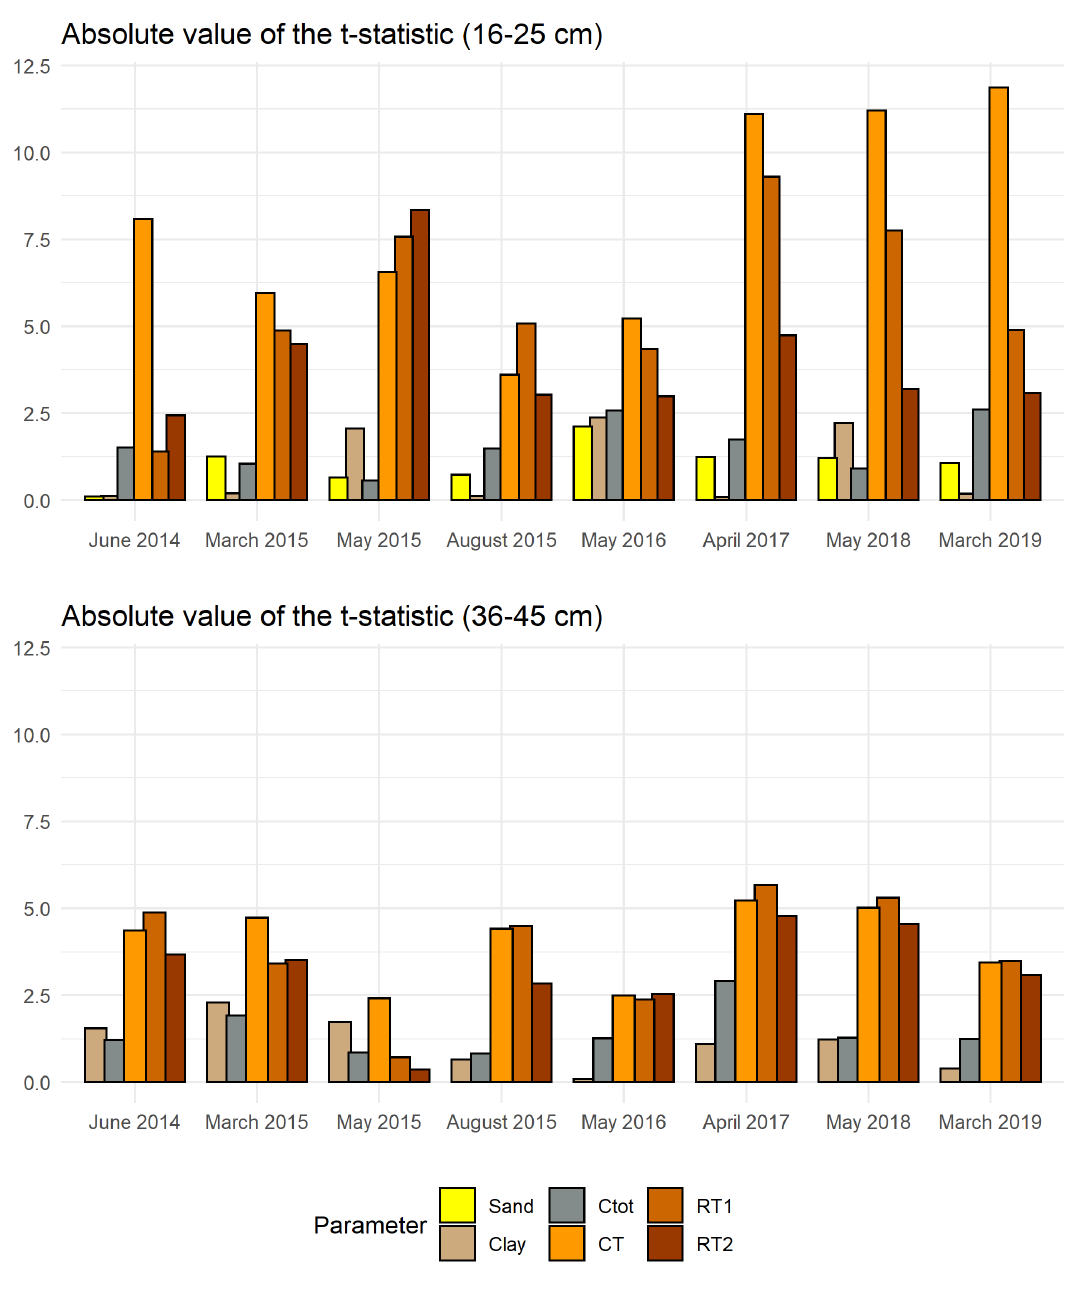
Figure 7. Importance of the variables expressed by the absolute value of the t-statistic for each parameter of the MLR models used to interpolate the penetration resistance (Figures 5 and 6; CT: continuously conventional tilled plot, both reduced tilled plots affected by one-time inversion tillage (RT1: chisel plough; RT2: disc harrow); Ctot: total carbon).